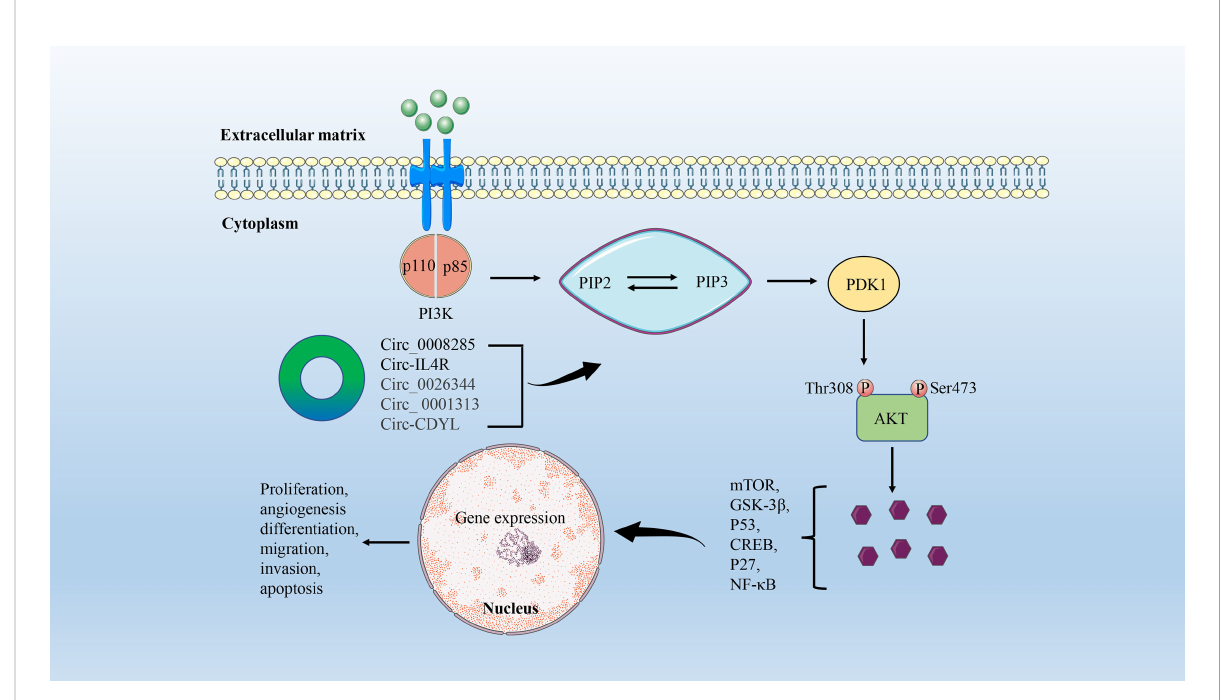
FIGURE 2 The circRNA/MAPK signaling axis in CRC. This signaling pathway is initiated by the binding of activated growth factors, such as epidermal growth factor (EGF), to tyrosine kinase receptors on the cell surface. This causes the downstream RAS to increase the GTP binding state. RAS-GTP dimers recruit RAF or RAF/MEK dimers to the plasma membrane and promote the activation of RAF and the formation of MEK homologous dimers. This is followed by activation and phosphorylation of downstream ERKs. Finally, ERKs induce phosphorylation of transcription factors and other substrates to participate in cell proliferation, differentiation, migration, and apoptosis in the